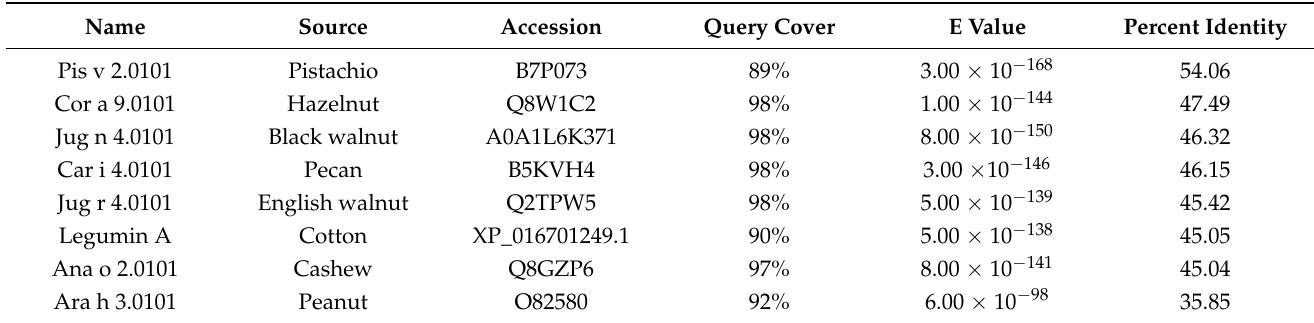
Table 4. Legumin B Sequence Homology.